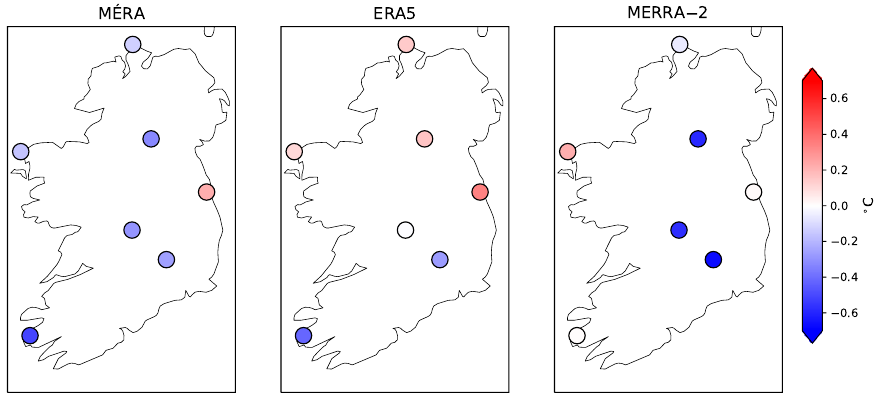
Figure 2. Mean Error (ME) for 2 m temperature at each station for each